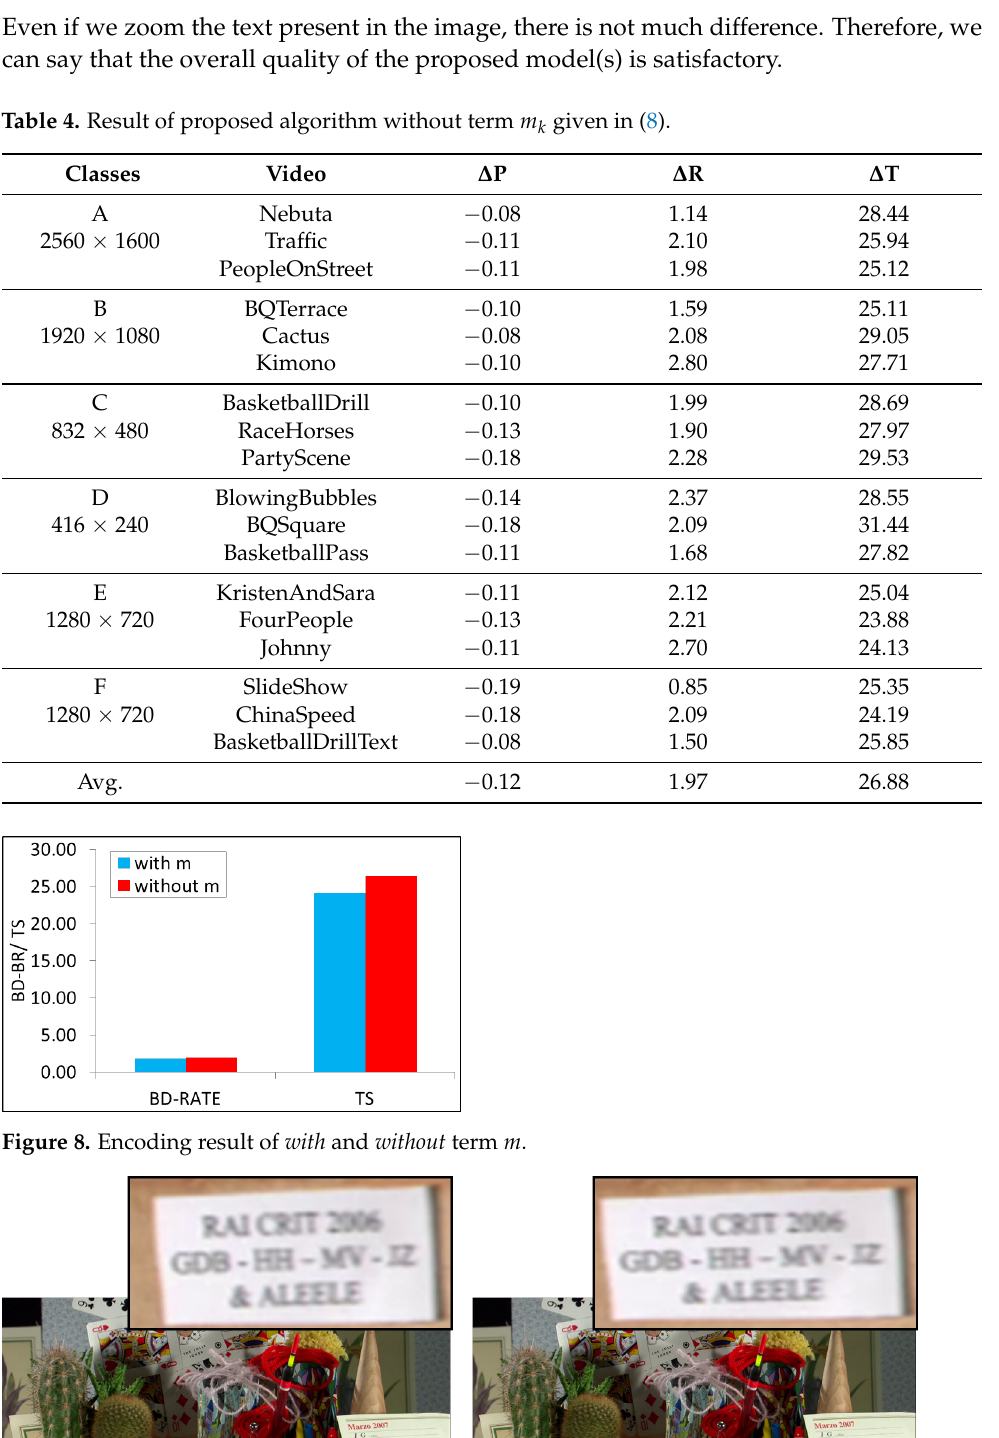
Table 4. Result of proposed algorithm without term m k given in (8).